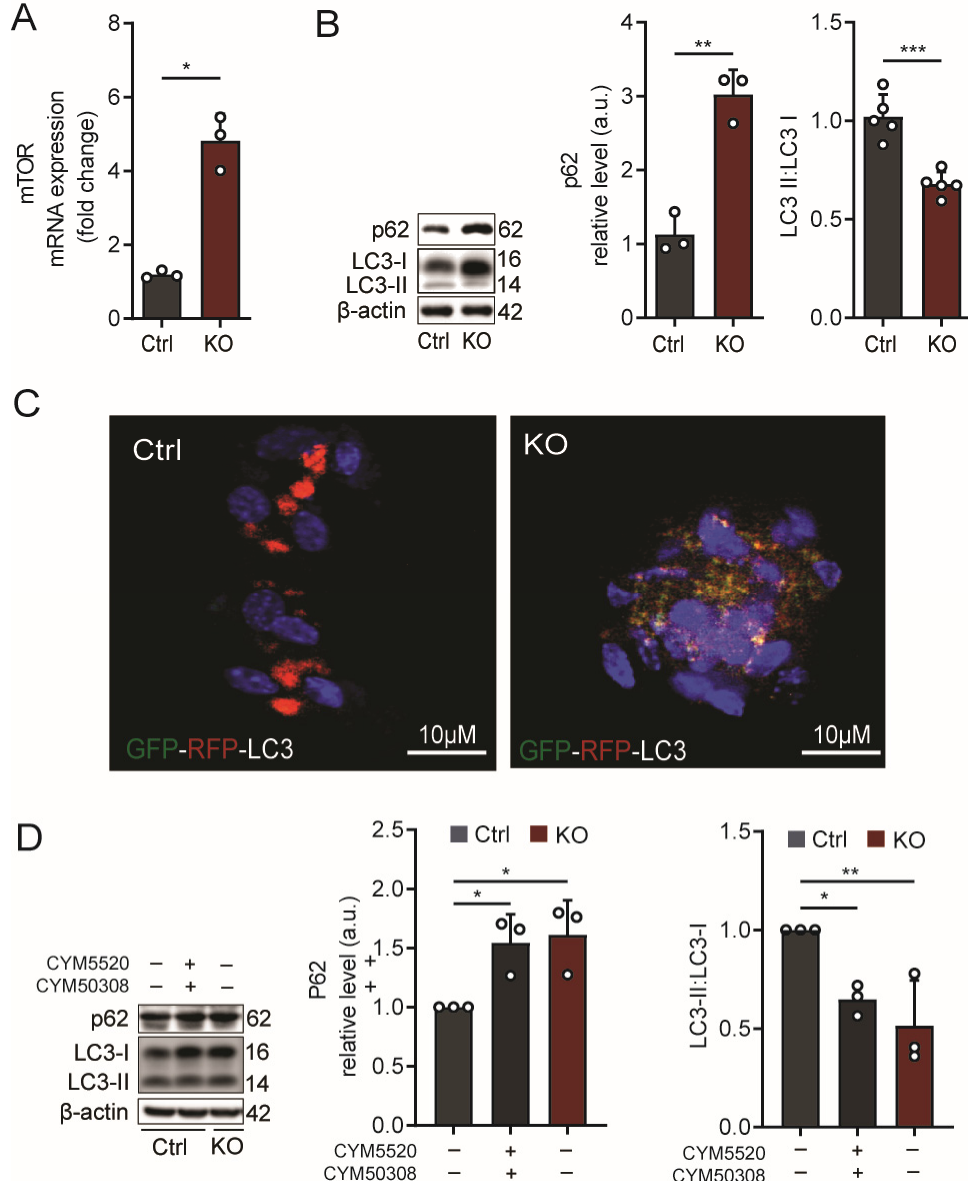
Figure 3. S1P activates mTOR and inhibits autophagy via S1PR 2/4 in SGPL1-deficient astrocytes. ( A ) Transcript quantification of mTOR in SGPL1-deficient astrocytes (KO) relative to controls (Ctrl) by qPCR using β -actin as reference. ( B ) Quantification of autophagy marker proteins p62 and LC3-II:LC3-I and ( C ) representative images showing the fluorescence of the RFP–GFP–LC3 construct in cultured astrocytes from control (Ctrl) and SGPL1 fl/fl/Nes (KO) mice. Red puncta represent autolysosomes, whereas yellow puncta represent autophagosomal structures. DAPI staining indicates cell nuclei in blue. Scale bar: 50 µm. ( D ) Protein quantification of p62, LC3-I, and LC3-II following stimulation (+) of control astrocytes with a combination of specific agonists of S1PR 2 (5 µM CYM5520) and S1PR 4 (5 µM CYM50308), ( − ) represents without stimulation for 24 h. For all, representative immunoblots are shown with β -actin as loading control. Bars represent means ± SEM, n ≥ 3, unpaired Student’s t -test; one-way ANOVA with Bonferroni multiple comparison test, * p < 0.05, ** p < 0.001, *** p < 0.0001.